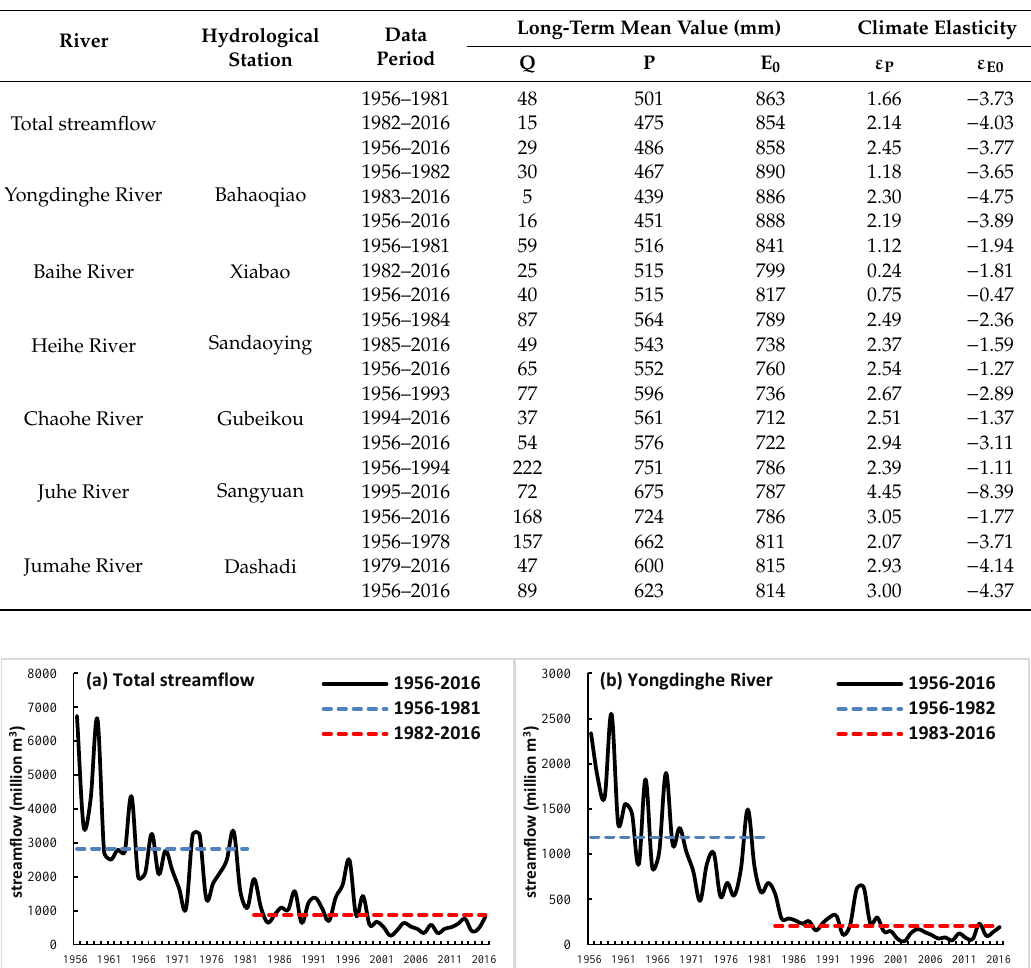
Table 2. Streamflow depth, precipitation, potential evapotranspiration, and climate elasticity over the di ff erent periods.